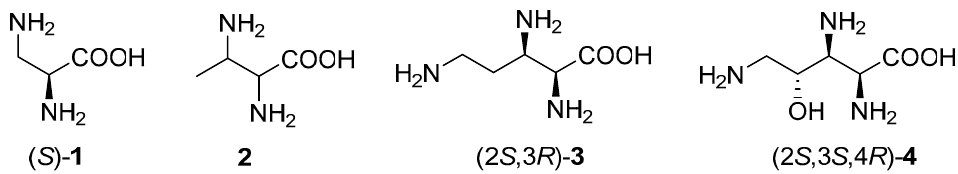
Figure 1. Examples of naturally occurring polyamino acids.